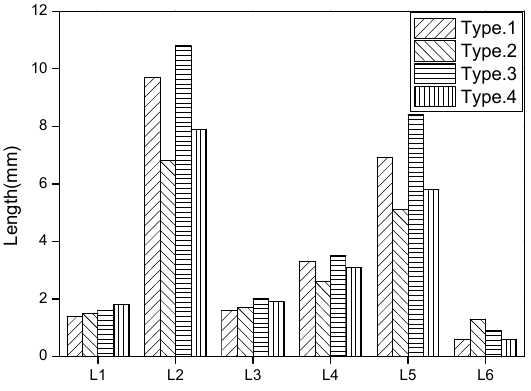
Figure 10. Measured length of each part on the weld bead.